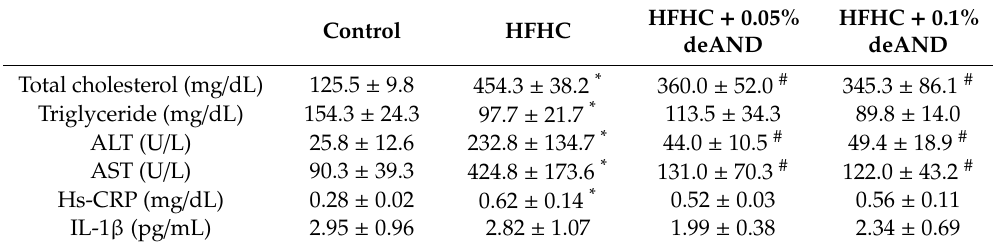
Table 3. Plasma biochemical parameters a